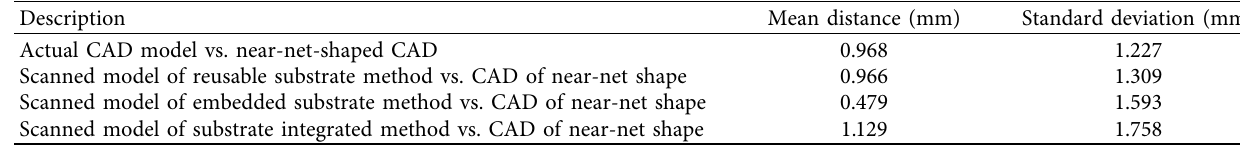
Table 2: Cloud-to-mesh distance of components fabricated using different build strategies.